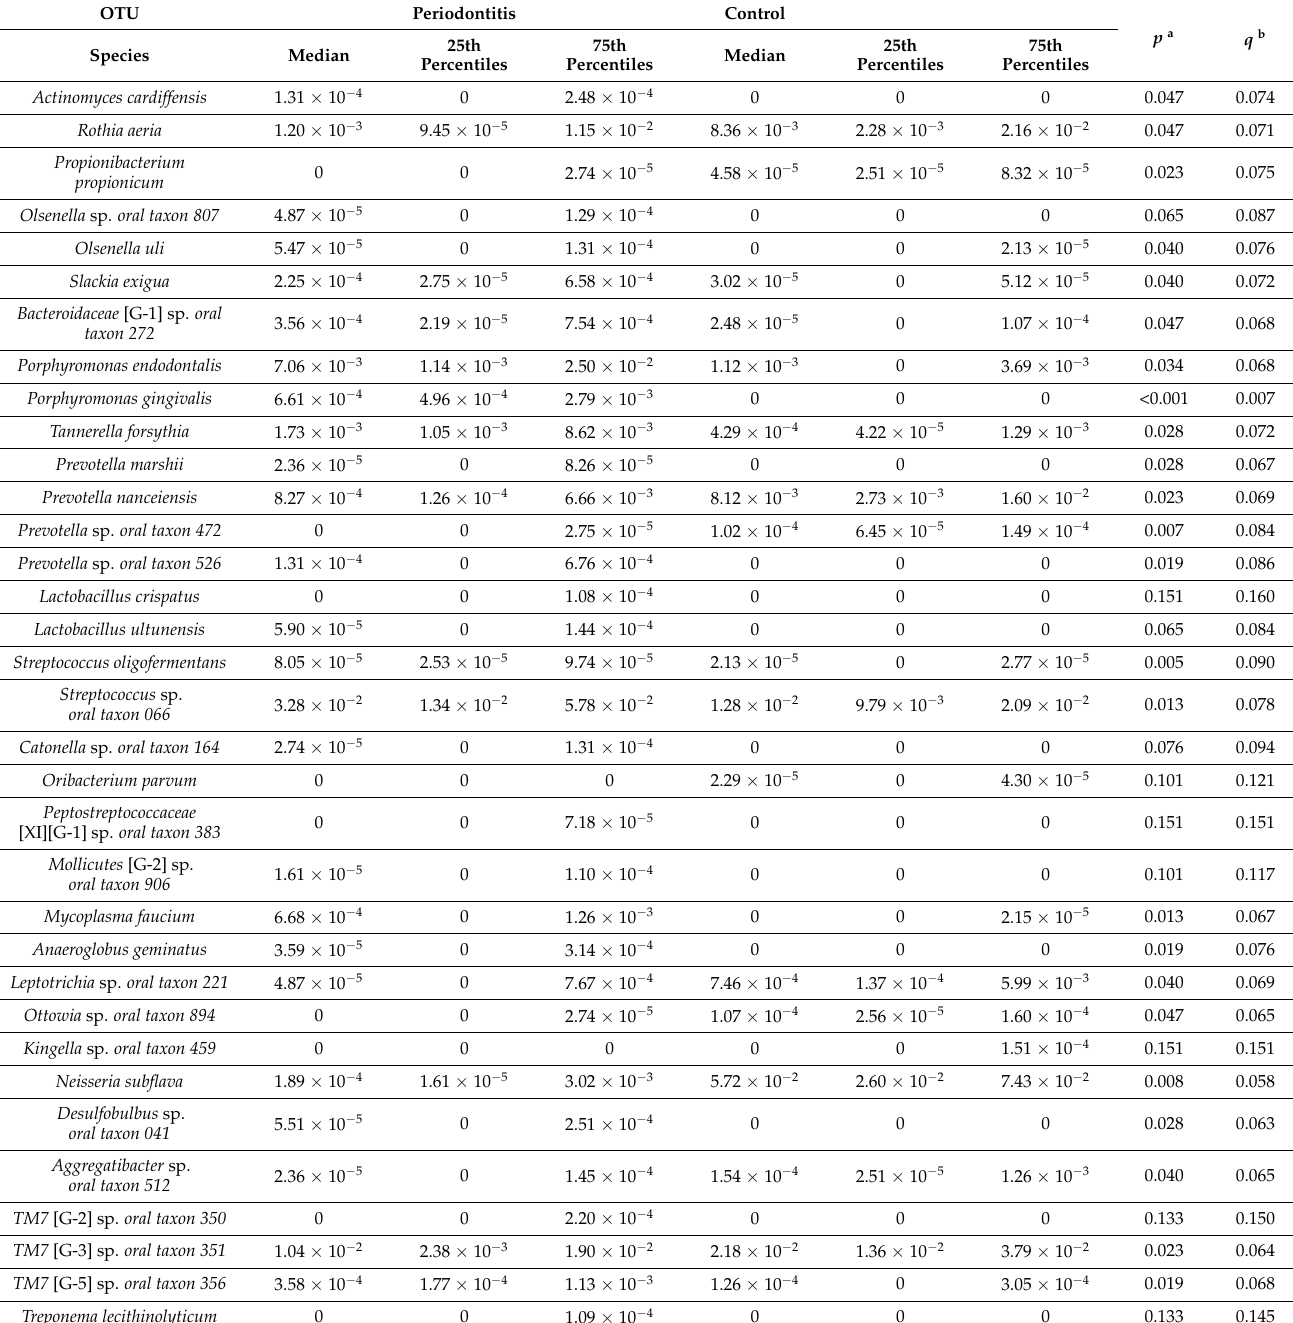
Table 2. Differences in operational taxonomic units (OTUs) between the periodontitis and control